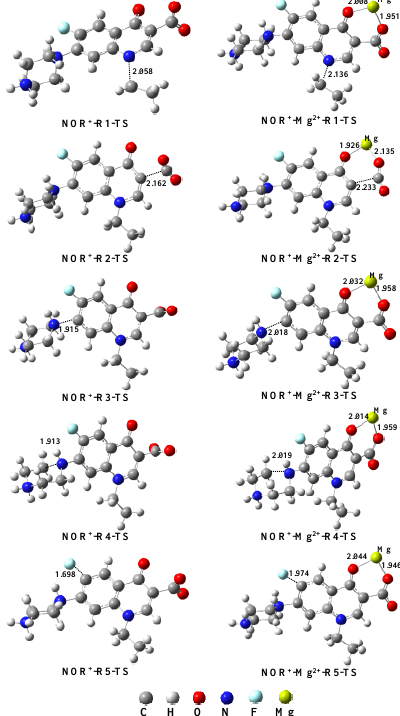
Figure 4. The transition state geometries of direct photolysis pathways R1, R2, R3, R4, and R5 of NOR +